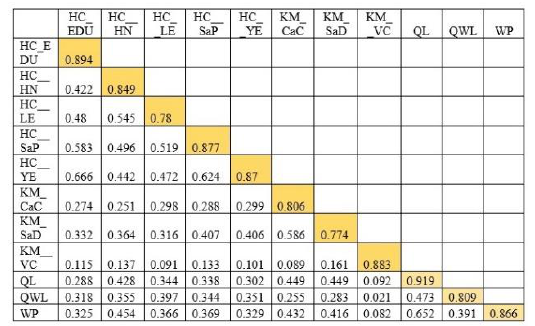
Table 5: Fornell and Locket Criterion